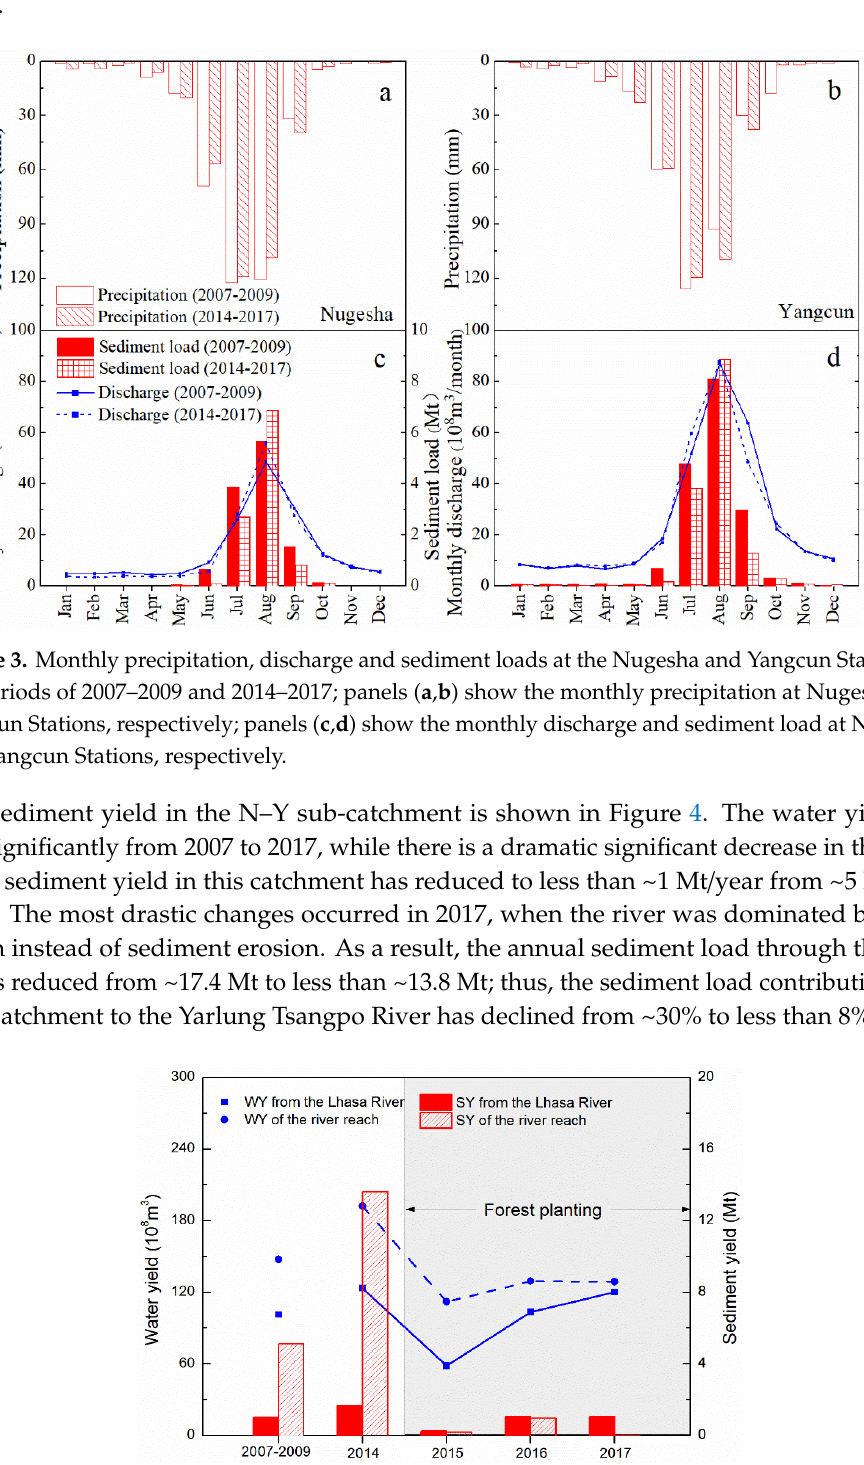
Figure 4. Water and sediment yields of the N–Y catchment.